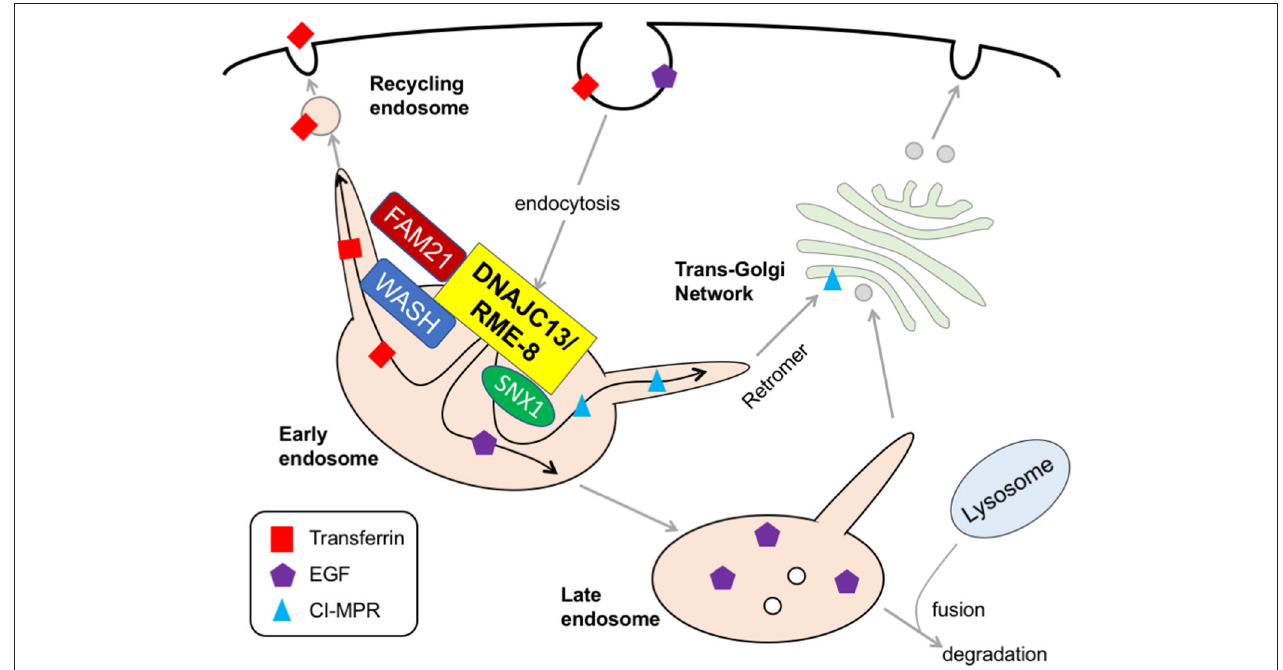
FIGURE 3 | DNAJC13/RME-8. At the surface of early endosome, DNAJC13 interacts with FAM21 tail in the WASH complex and SNX1, thereby controlling the formation of tubular structure on endosome surface where a retromer-mediated cargo transport (e.g., CI-MPR) occurs. DNAJC13 also play important roles in the recycling and the degradation of transferrin and EGFR, respectively. RME-8, receptor-mediated endocytosis-8; FAM21, family with sequence similarity 21; WASH, Wiskott–Aldrich syndrome protein and Scar homolog; SNX1, sorting nexin 1; EGF, epidermal growth factor; CI-MPR, cation-independent mannose 6-phosphate